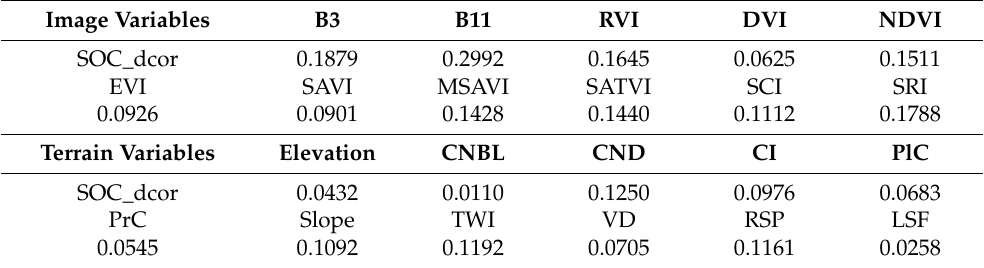
Table 2. Distance correlation coefficients between SOC and predictor